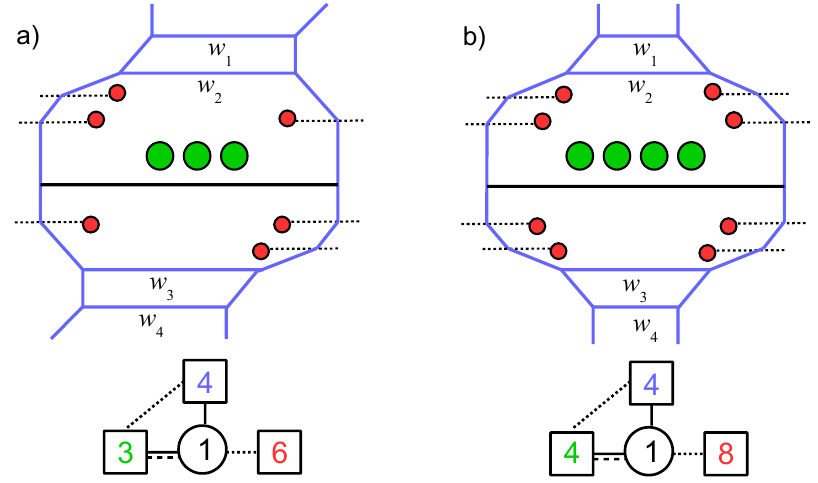
Figure 7 . Complete brane systems for the L 1 bubbling in: a) the SU(3) N f = 6 theory; b) the SU(4), N f = 8